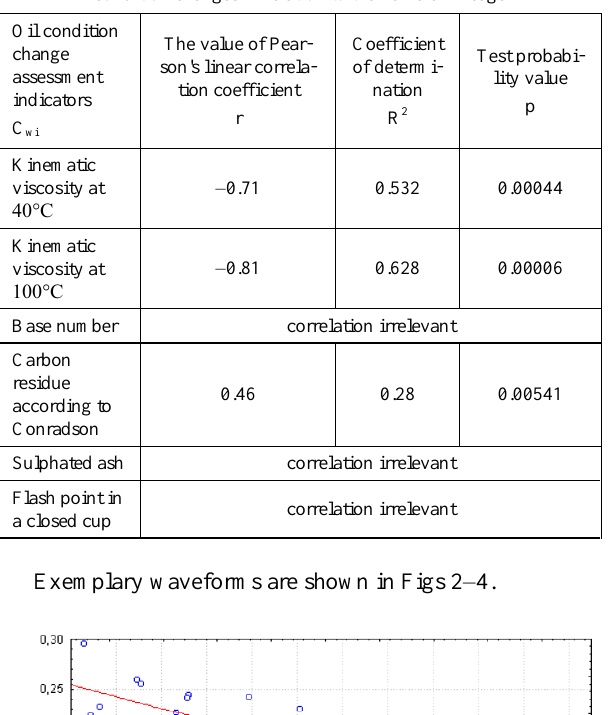
Table 2. List of linear correlation coefficients for the assessment of oil condition changes in relation to the vehicle mileage